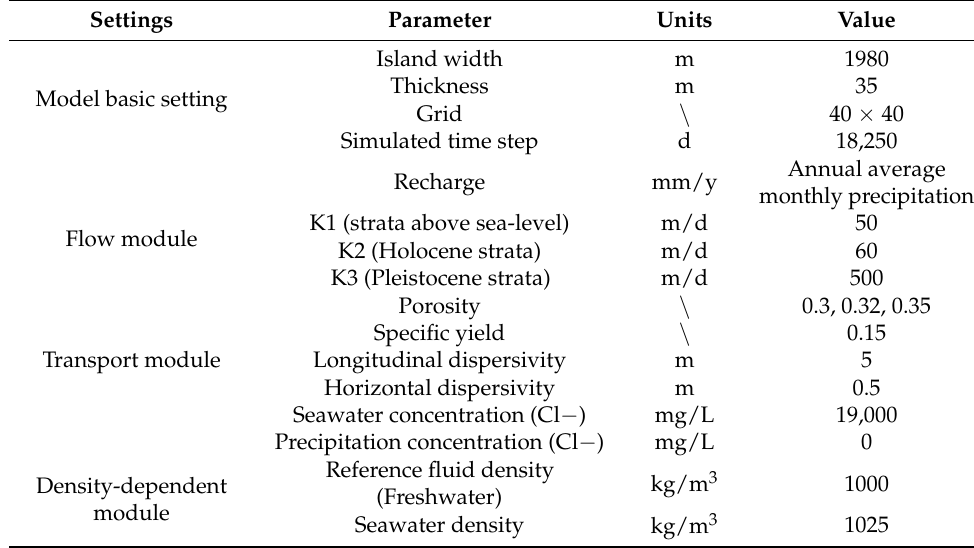
Figure 2. Basic model grid and boundary conditions. Table 1. Parameter values used in the basic model.